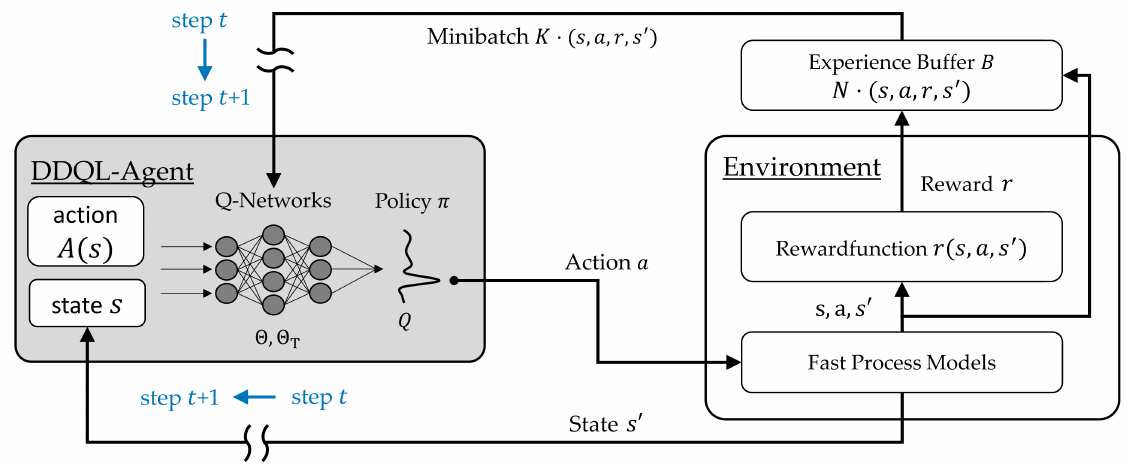
Figure 4. Schematic simplified representation of the implemented DDQL